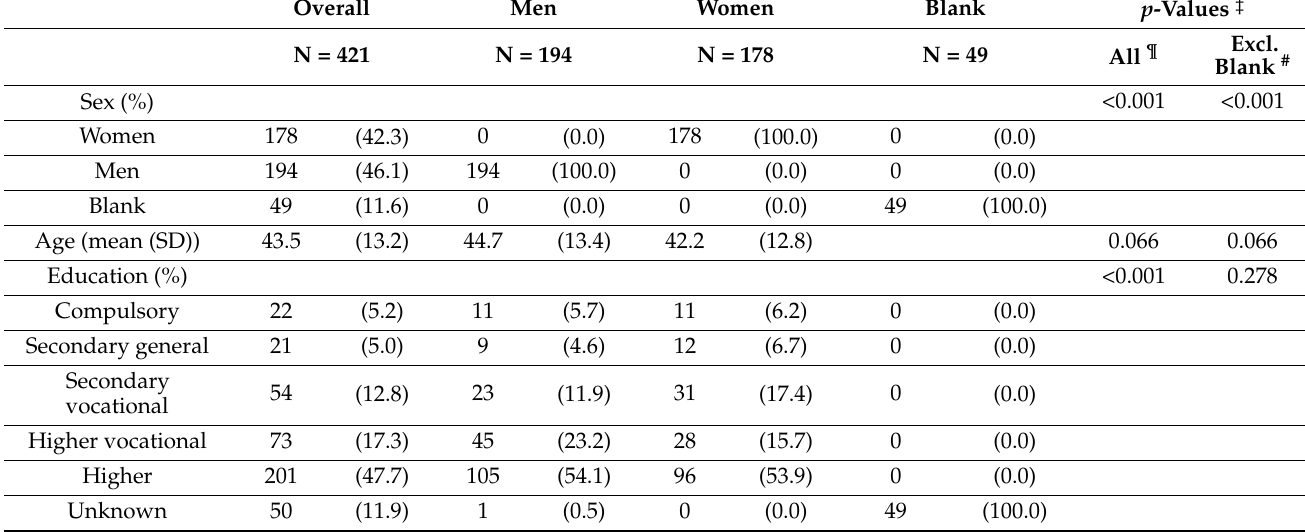
Table 1. Respondent demographic